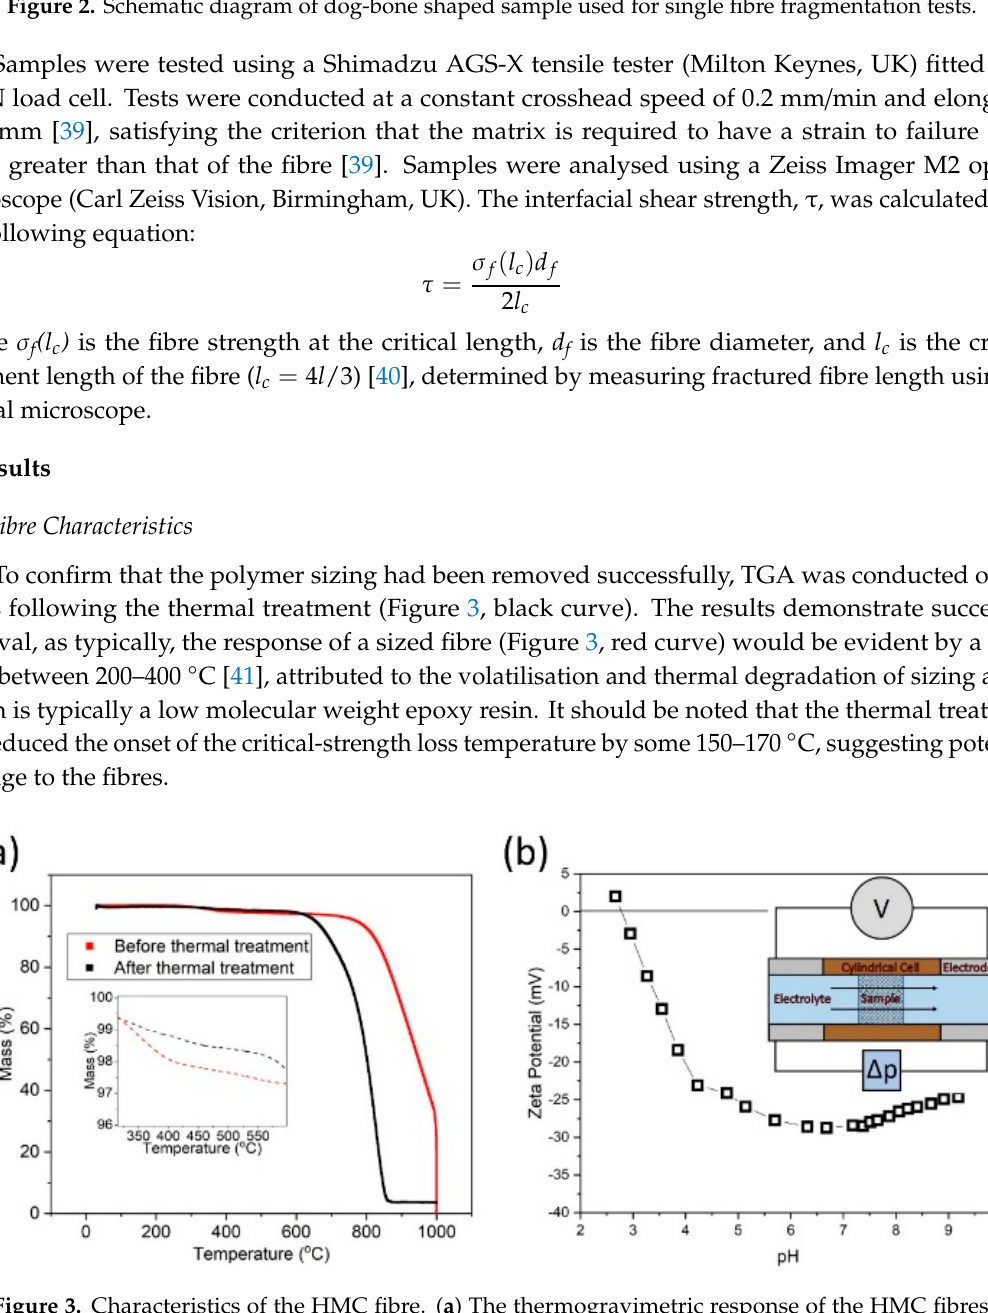
Figure 3. Characteristics of the HMC fibre. ( a ) The thermogravimetric response of the HMC fibres, (inset): in the region of the degradation point of the polymer sizing. ( b ) The streaming zeta potential of HMC fibres. (For interpretation of the references to colour in this figure, the reader is referred to the web version of this